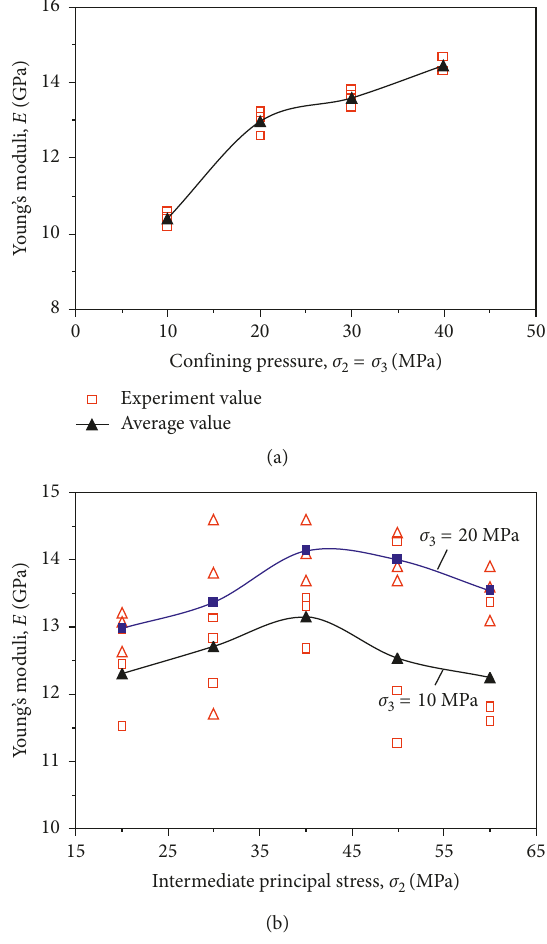
Figure 8: Influence of the confining pressure on Young’s modulus of sandstone: (a) CTT; (b) TTT.